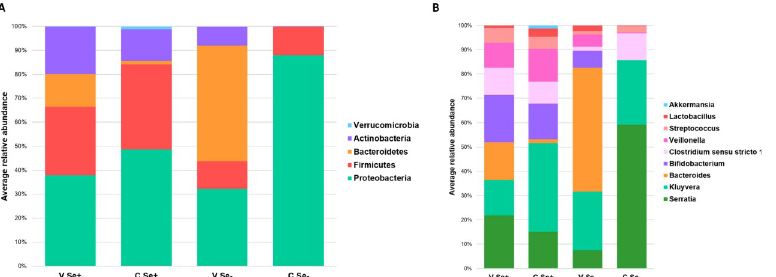
Fig 2. Average relative abundances of the most abundant bacterial phyla (A) and genera (B) of the infant fecal microbiota according to the birth mode and maternal secretor phenotype. The taxa with an average relative abundance < 1% were removed and those with an average relative abundance � 1% were set to 100%; VSe+: Vaginally born, secretor; CSe+: Cesarean born, secretor; VSe-: Vaginally born, non-secretor; CSe-: Cesarean born, non-secretor.